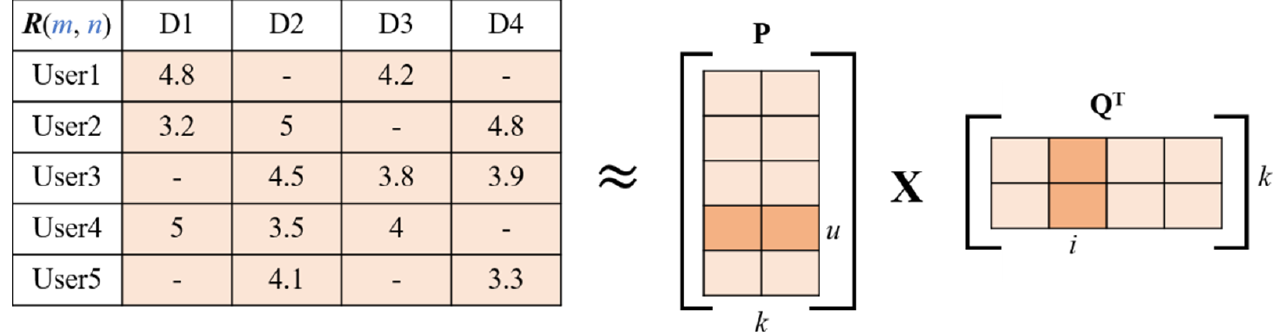
Figure 31. Intuitive representation of the Principle of Matrix Decomposition.